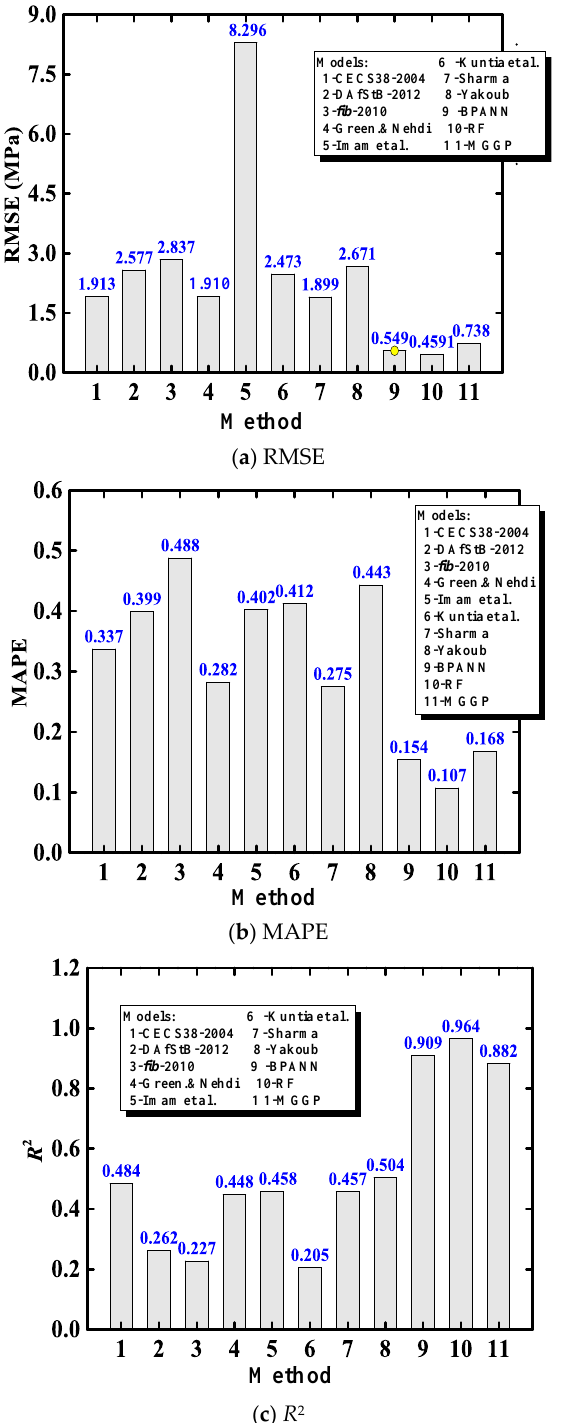
Figure 7. Comparison of prediction performance of different models.